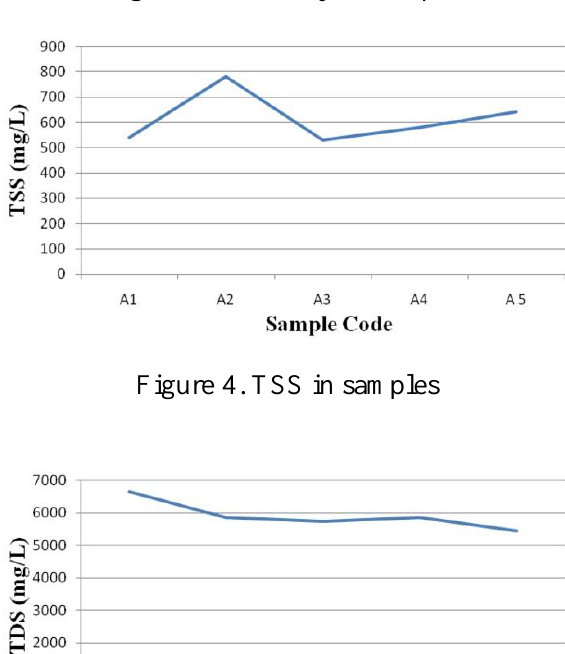
Figure 3. Turbidity of samples